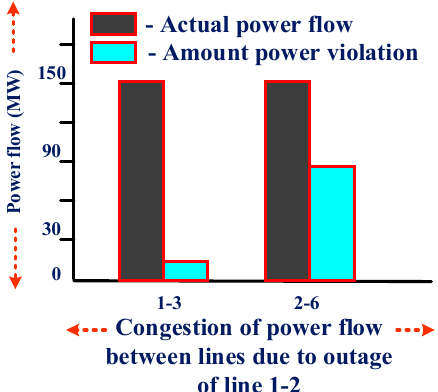
Table 3. Comparison of congested line flow.